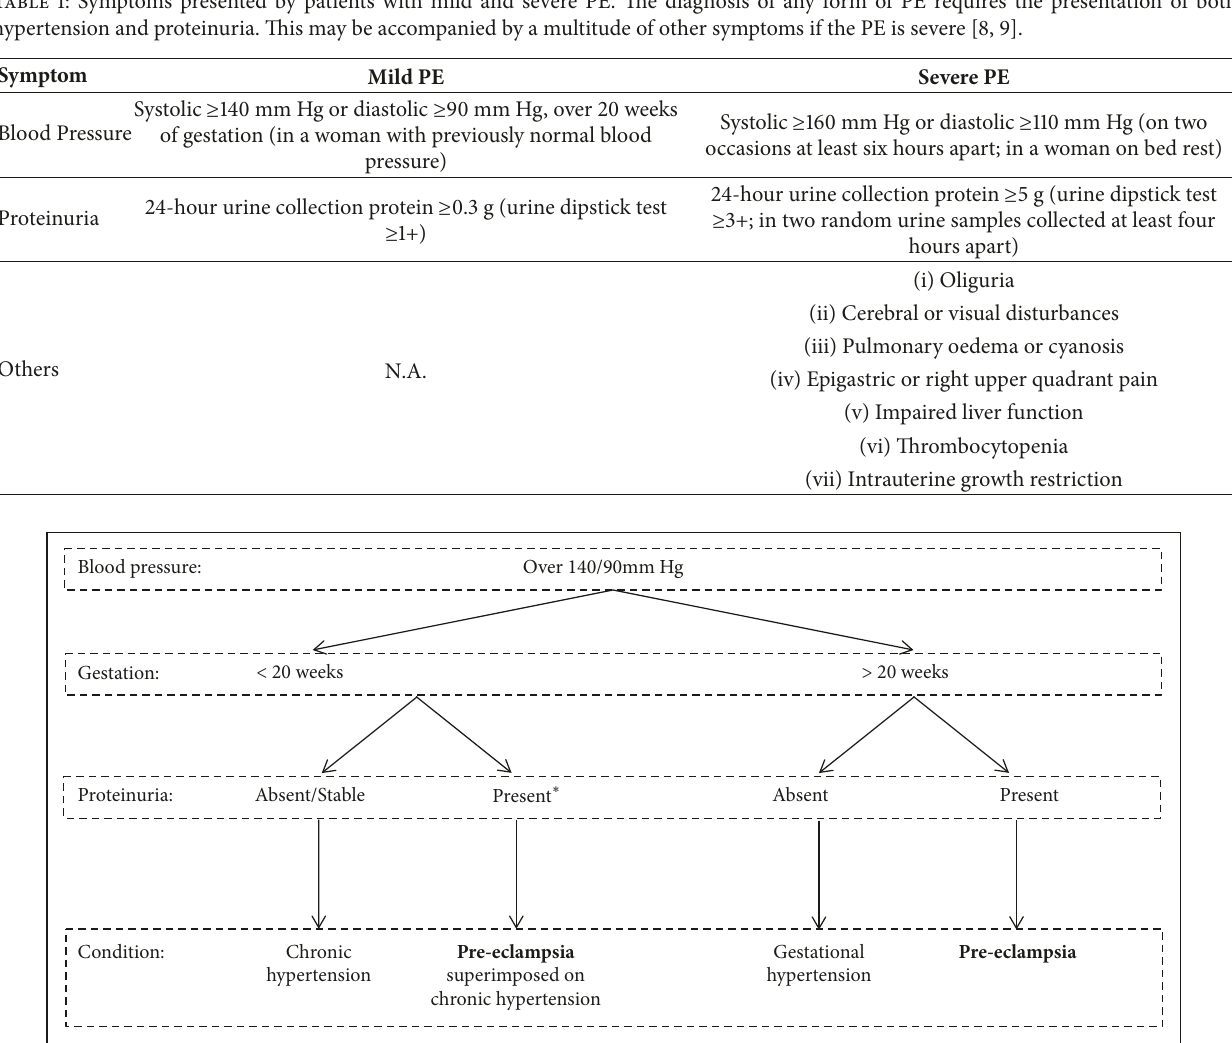
Figure 1: Simplified diagnostic information for the distinction of different types of hypertension and preeclampsia. ∗ In the form of new or increased proteinuria, together with development of increasing blood pressure, or HELLP syndrome